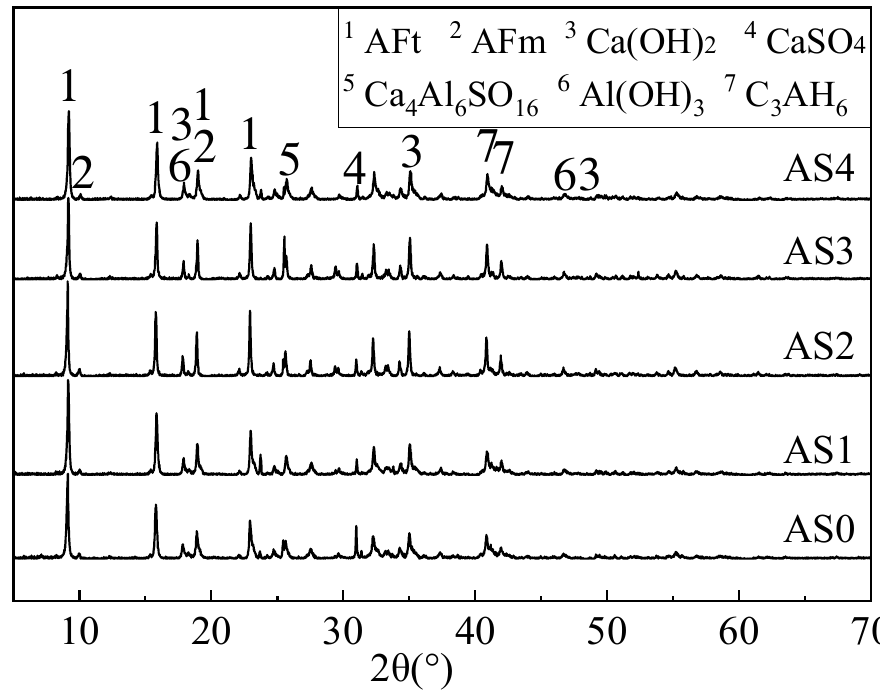
Figure 10. XRD patterns of the double liquid grouting materials with different aluminum sulfate contents at 28 days.